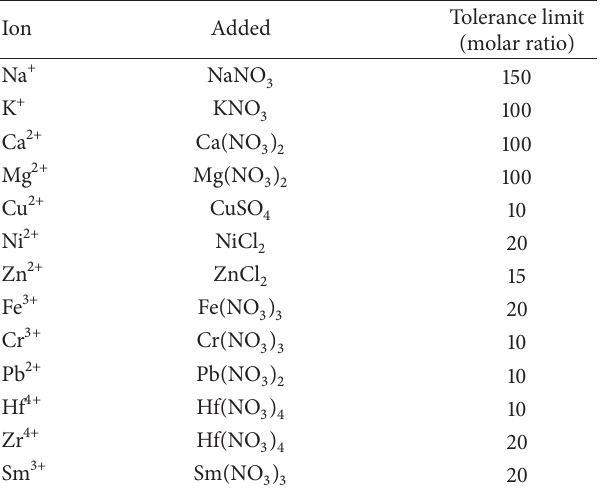
Table 2: Effect of diverse ions on the determination of Th(IV) (relative error ± 5.0%).